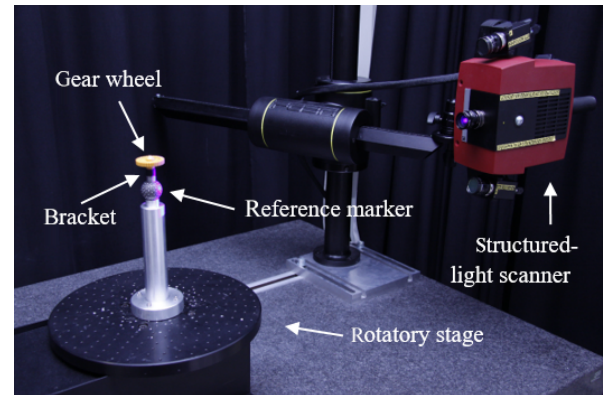
Figure 3. Figurative representation of the measurement setup, con- sisting of a structured-light scanner (here GOM ATOS Compact Scan 2M/300) in combination with a rotatory